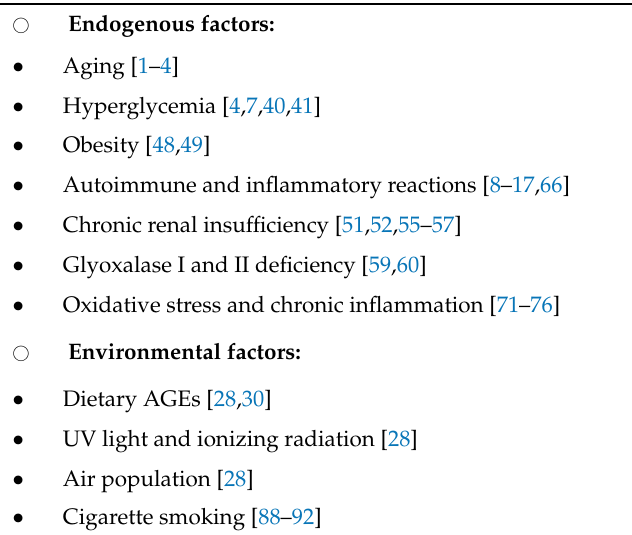
Table 1. Factors a ff ecting advanced glycation end product (AGE)